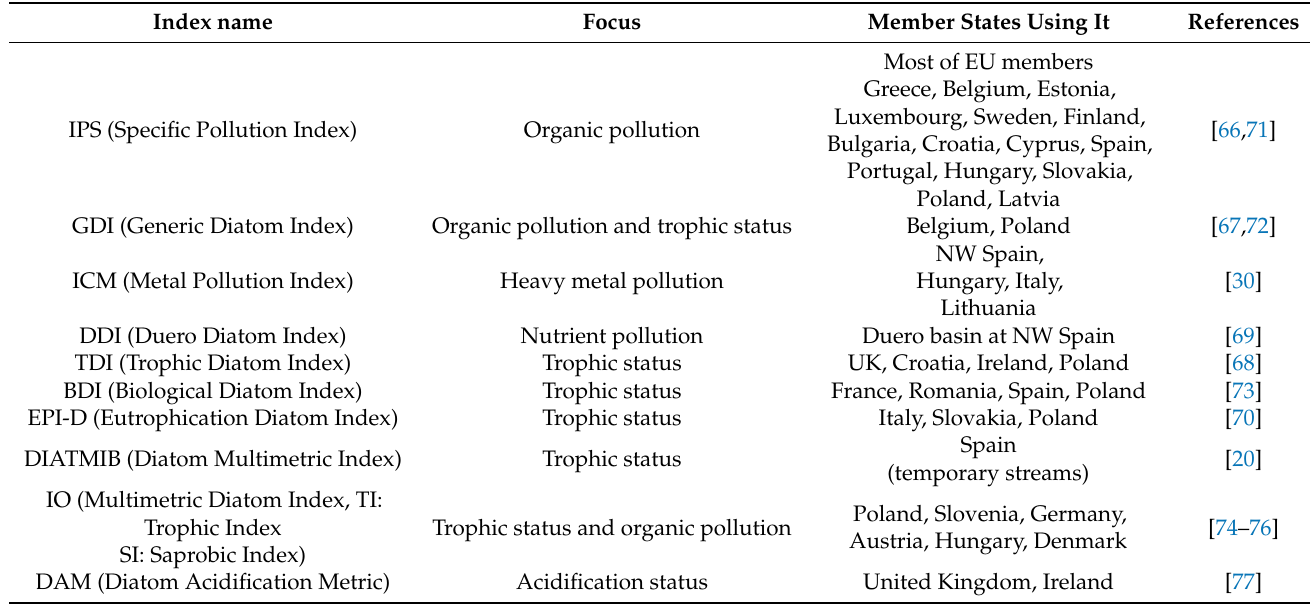
Table 2. Most used species-based indices for water quality assessment in the